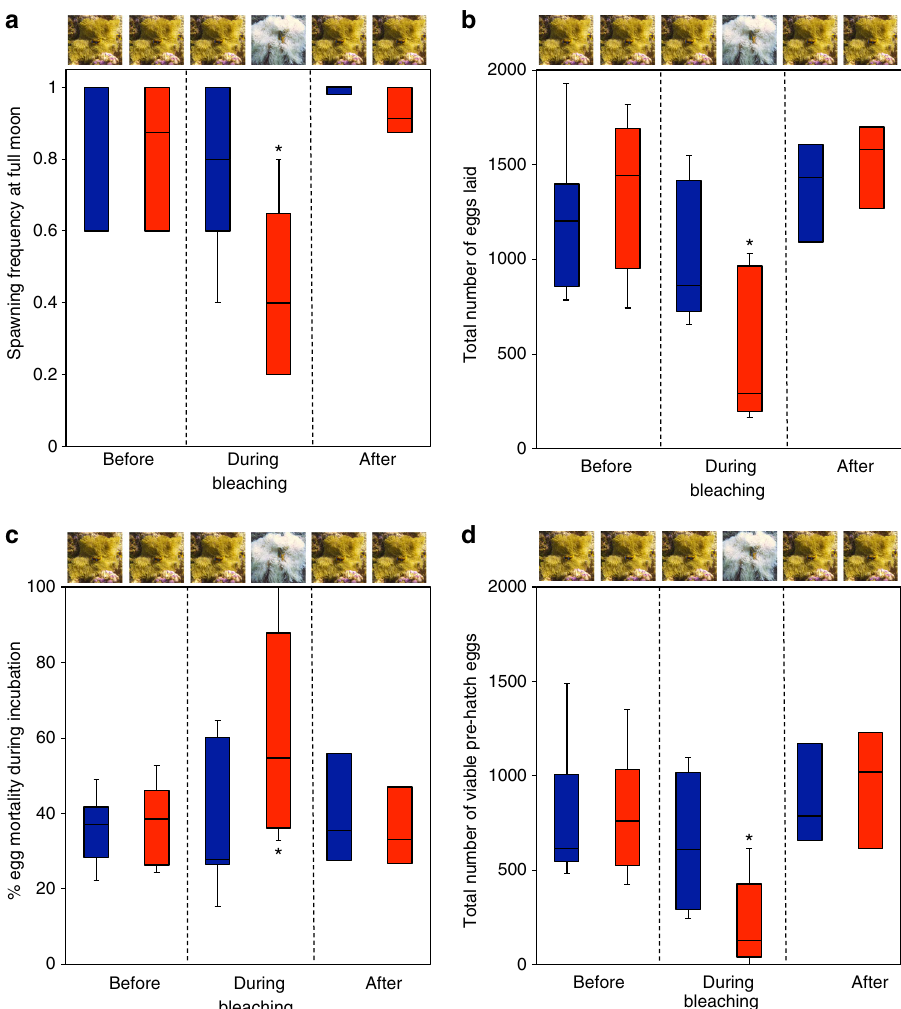
Fig. 5 Effect of exposure to warming-induced anemone bleaching on free-living adult anemone fi sh reproductive function during the bleaching event compared to before and after. a Spawning frequency (Wilcoxon Signed Ranks Test: before, Z 5 = 2.003, P = 0.045; after, Z 5 = 2.207, P = 0.027). b Total number of eggs laid per full moon (Paired t -tests: before, t 5 = 4.965, P = 0.004; after, t 5 = 5.205, P = 0.003). c Total proportion of egg mortality (Wilcoxon Signed Ranks Test: before, Z 5 = 1.992, P = 0.046; after, Z 5 = 1.992, P = 0.046). d Total number of viable pre-hatch eggs (Paired t -tests: before, t 5 = 6.585, P = 0.001; after, t 5 = 3.897, P = 0.011). Anemone fi sh before, during and after being exposed to bleached ( red boxplots ) and unbleached ( blue boxplots ) anemones. Values are median, interquartile range, minimum, and maximum. Asterisk denotes signi fi cance P <